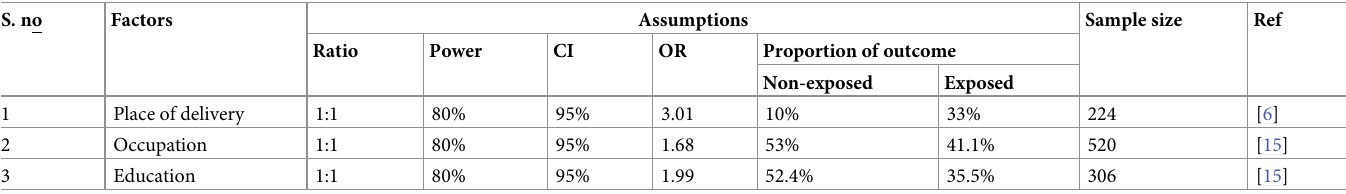
Table 1. Sample size determination to assess GMP utilization,